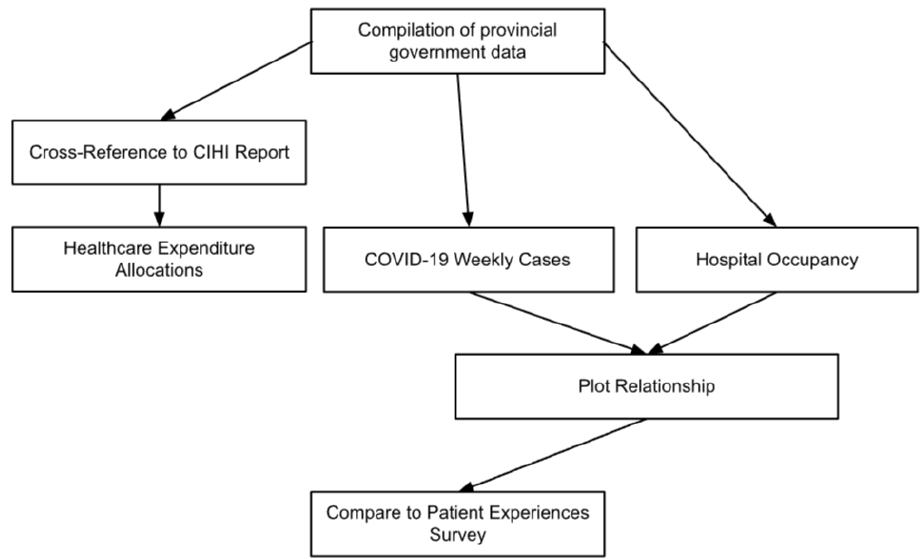
Figure 1. Workflow of data acquisition, analysis and comparison.